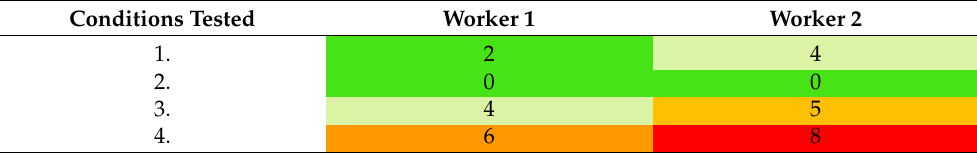
Table 4. Scores related to the discomfort perceived by the workers across the four conditions.